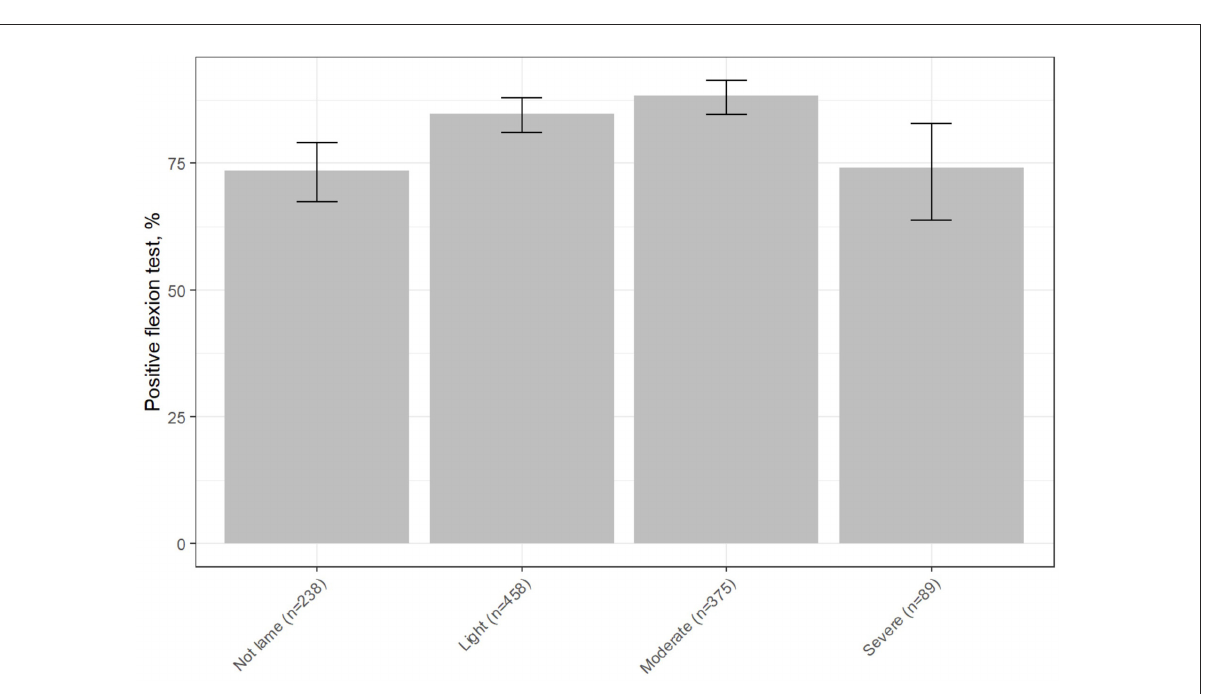
Figure 4 shows the percentage of positive FTs obtained when considering the initial lameness score of the patients: 73.5% for the non-lame dogs (95CI: 67.4–79.1; Figure 4), 84.7% for the mild scores (95CI: 81.2–87.9; Figure 3), 88.3% for the moderate